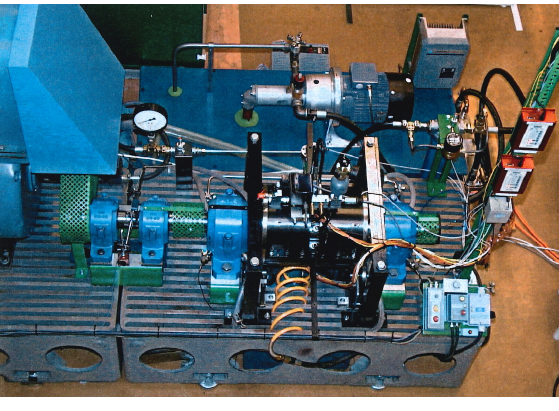
Figure 14: The test rig for the tilting-pad thrust bear- ing (Glavatskikh, 2000; Glavatskikh and Larsson,